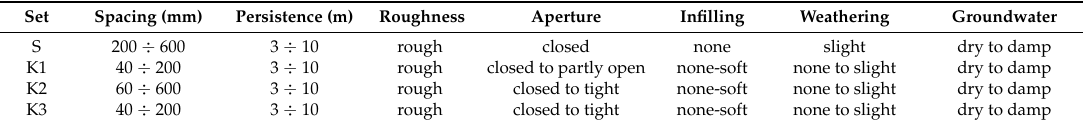
Table 2. Main geo-mechanical features from the